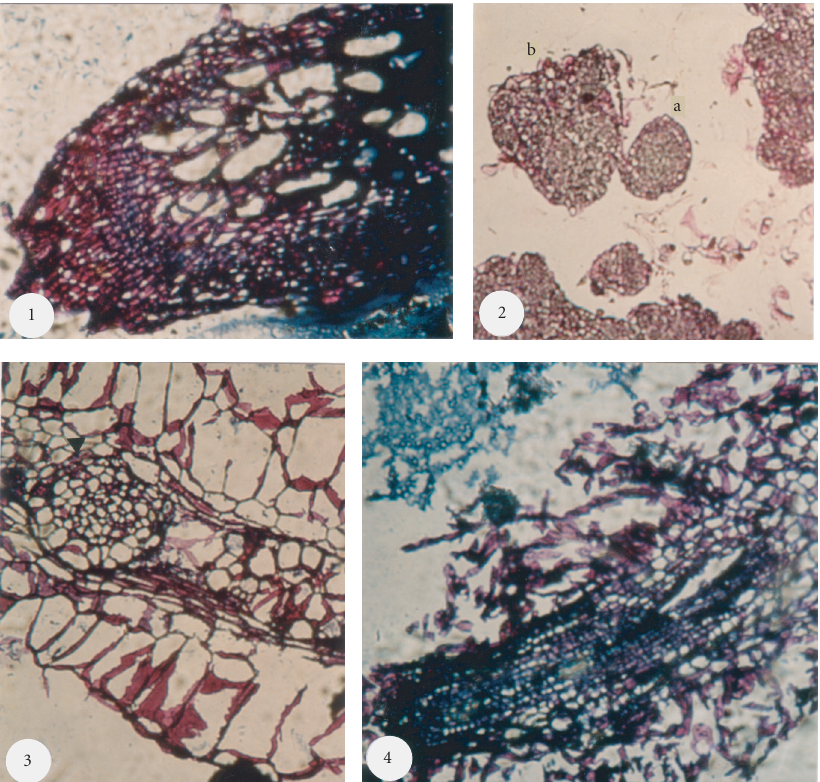
Figure 8: Histologic cuts of Papaver somniferum album cultures. (1) Roots of plants,at 3months,cultivated in soil ( × 10 ) ,(2) Embryogenous callus ( × 10 ) :2a,somatic embryo in globular stage;2b,somatic embryo in heart cotyledonary stage,(3) Rhizogenous callus ( × 10 ) :Presence of a meristematic zone that shows the depart of a secondary root,(4) Rhizogenous callus ( × 10 ) : Presence of vessels in helix. Scale: 1 cm = 1